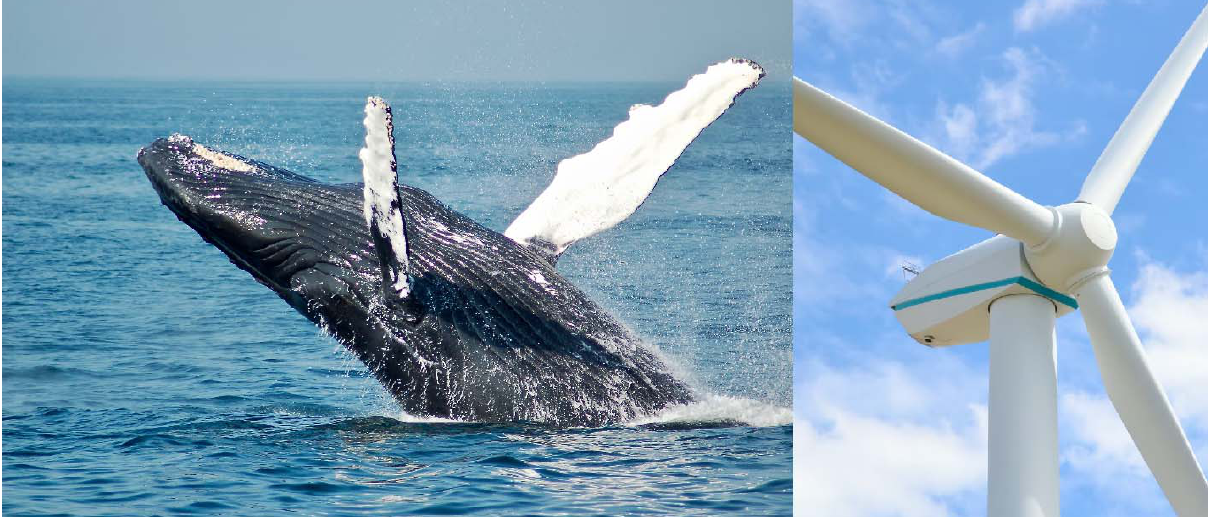
Figure 3. Humpback Whale and Wind Turbine blades.